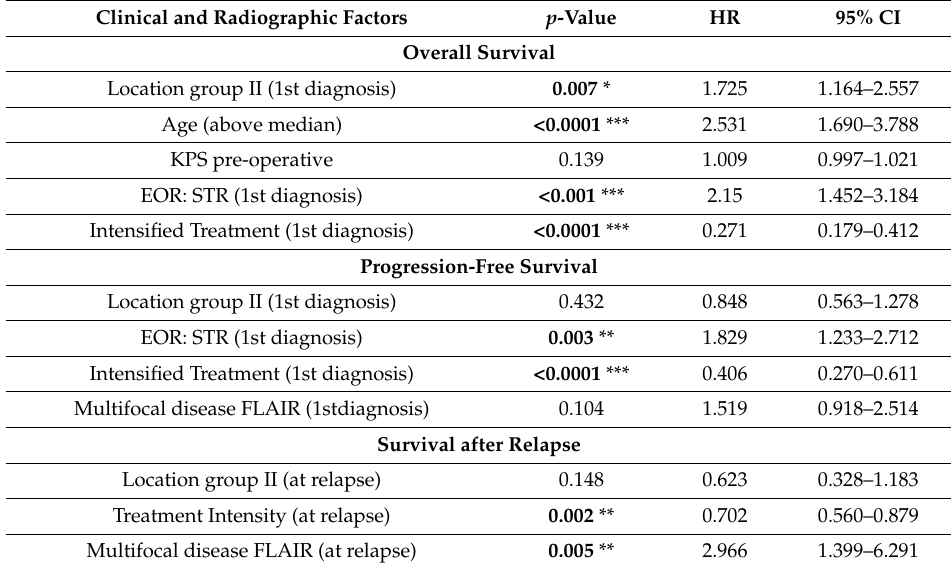
Table 3. Multivariate Analysis of Overall Survival ( n = 140), Progression-free Survival ( n = 140) and Survival after Relapse ( n = 59) for Group II versus Group III IDH1-Wildtype